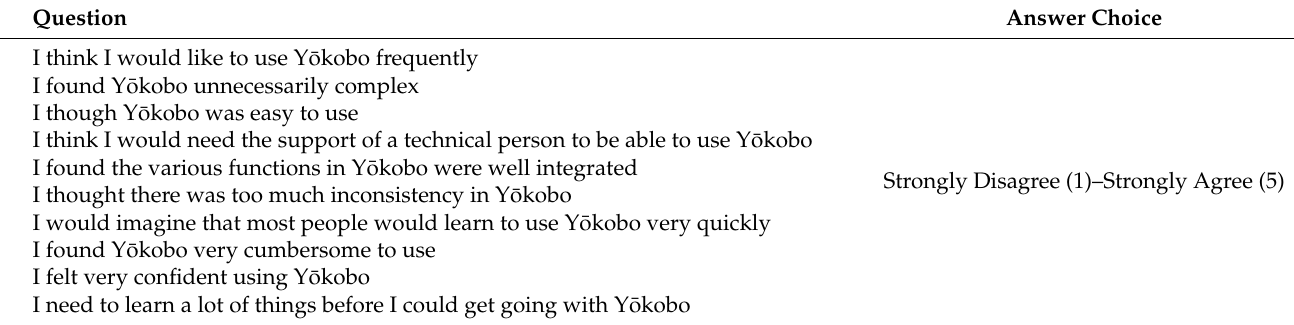
Table A3. SUS questions in QW2 for the selected participants, using a Likert